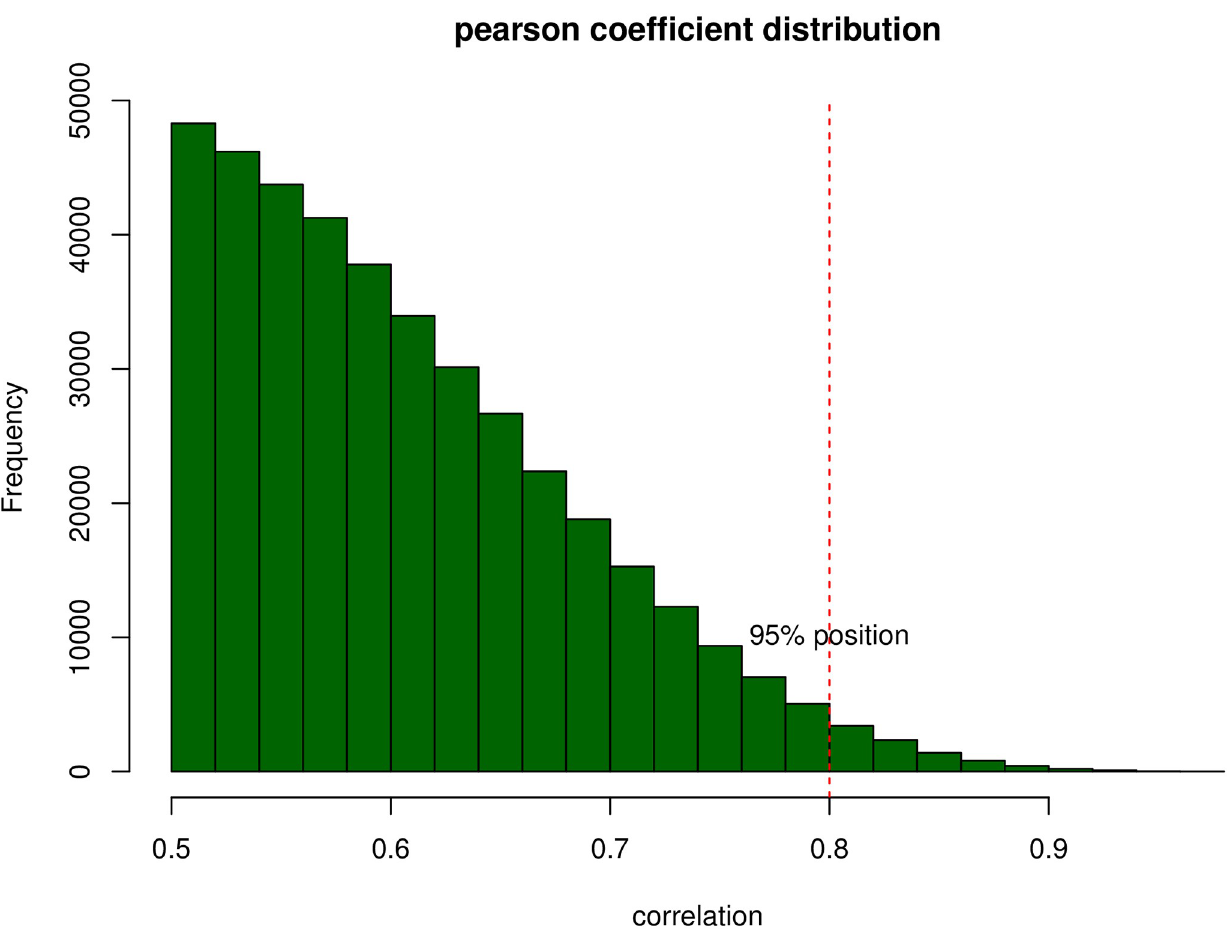
Fig 6. Pearson coefficient distribution. The x-axis represents the correlation efficiency and the y-axis represents the frequency.